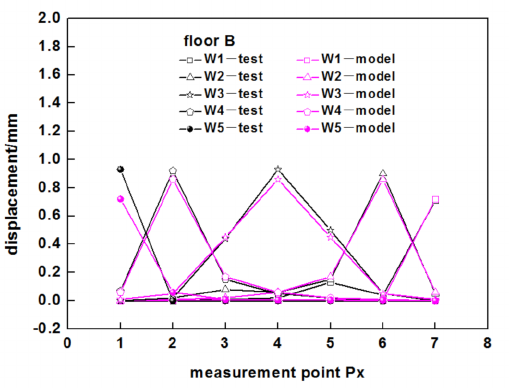
Figure 13. Experimental and modeled results of deflections of Floor B under W series point